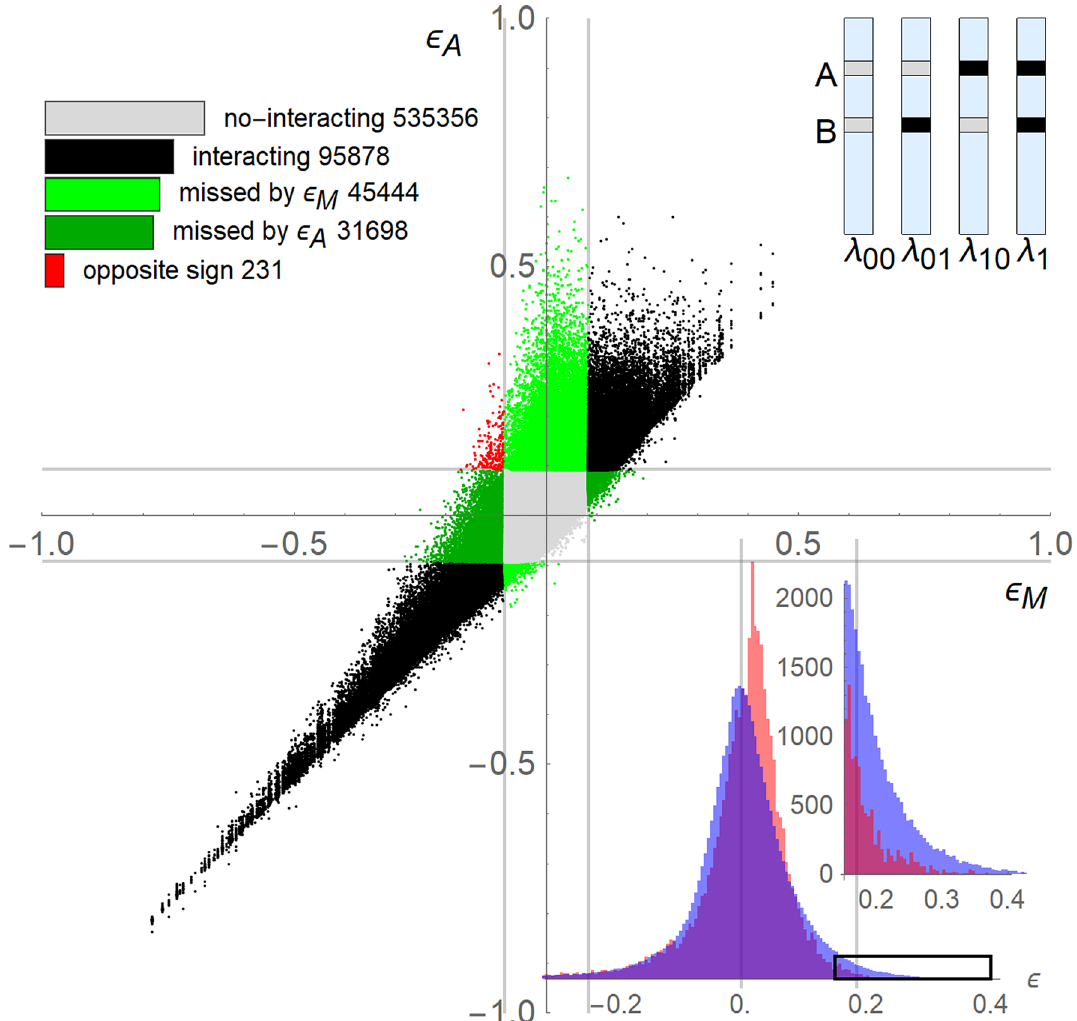
Figure 1. Diverging performance of two measures applied to the same interaction data. In the middle plot, genetic interaction for each pair of gene is computed with the measures ε M = (cid:31) 11 − (cid:31) 01 (cid:31) 10 (X axis), and ε A = (cid:31) 11 + 1 − (cid:31) 01 − (cid:31) 10 (Y axis). The color code corresponds to the bar-chart at the upper left. The parallel lines indicate the standard deviation limits, 0.083 and 0.092, for εM and εA, respectively. The count of the pairs per each category is shown in a logarithm scale in the bar-chart. The scheme at the upper right show a typical four genomes set from where interaction data are obtained for a given pair of genes. Gray and black segment of the genome denote respectively the wildtype and perturbed variant of the genes A and B. The growth rates of the corresponding yeast isogenic cultures, (cid:31) 01 and (cid:31) 10 corresponds to the single mutants, and (cid:31) 11 to the double mutant. The histograms at the bottom right show the distribution along the magnitude of interaction computed with measures εM (red profile) and εA (blue profile). The inset zooms the tail farther than one standard deviation toward the right